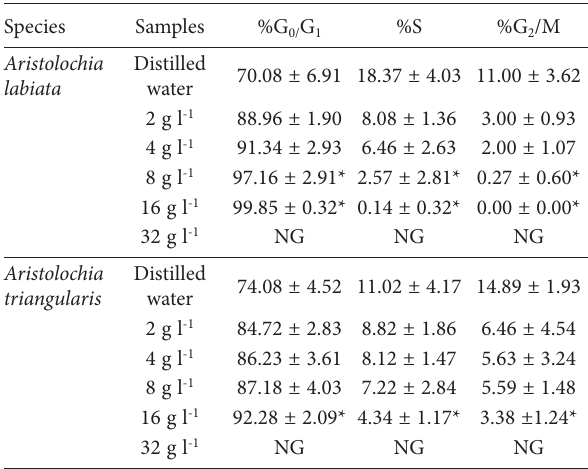
Distilled water: negative control. NG: did not germinate. * Signifi- cant difference in relation to negative control (p <0.05) - Kruskal- Wallis